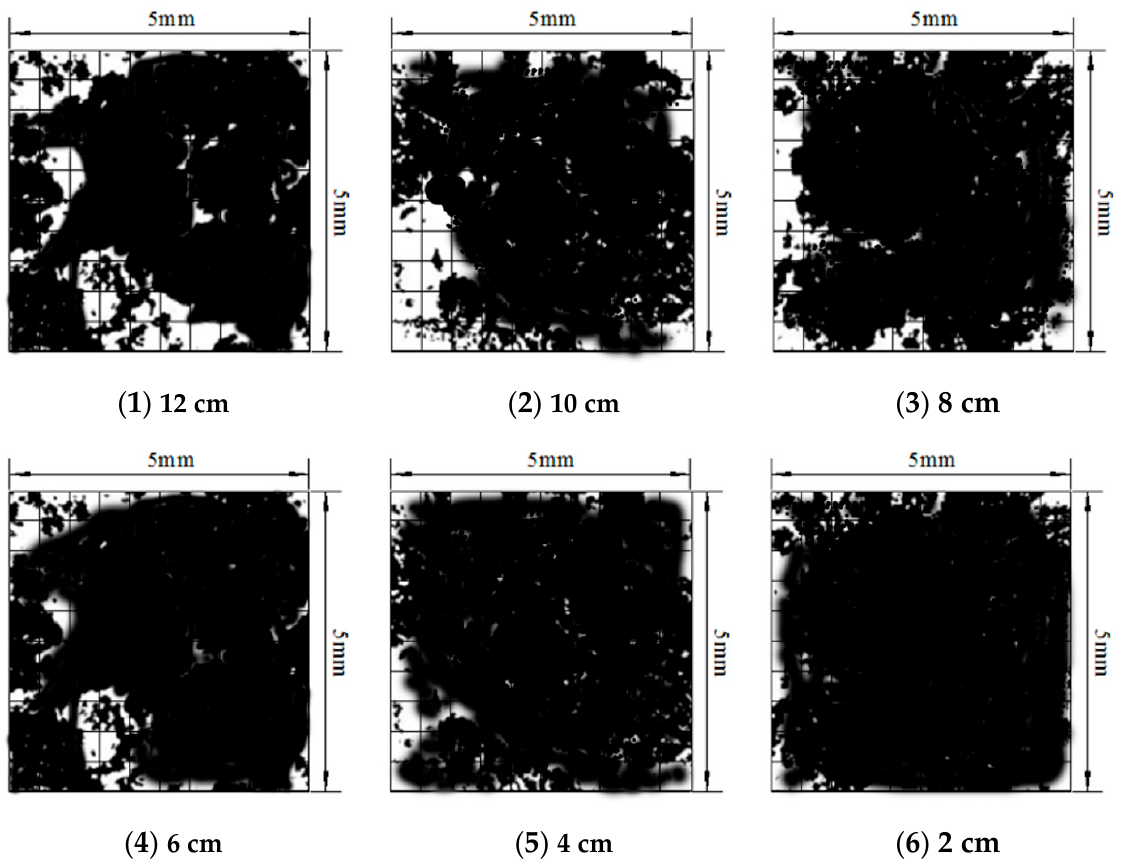
Figure 7. Binarization of bed seepage channel distribution images and box dimension calculation.